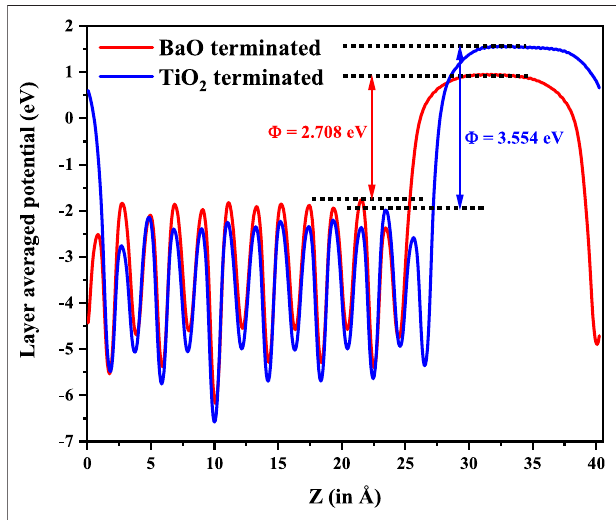
FIGURE 7 | Work function evaluated for BaO and TiO 2 termination at both end surfaces for 2 × 2 × 6.5 supercell of BaTiO 3 with Cu and Te co-